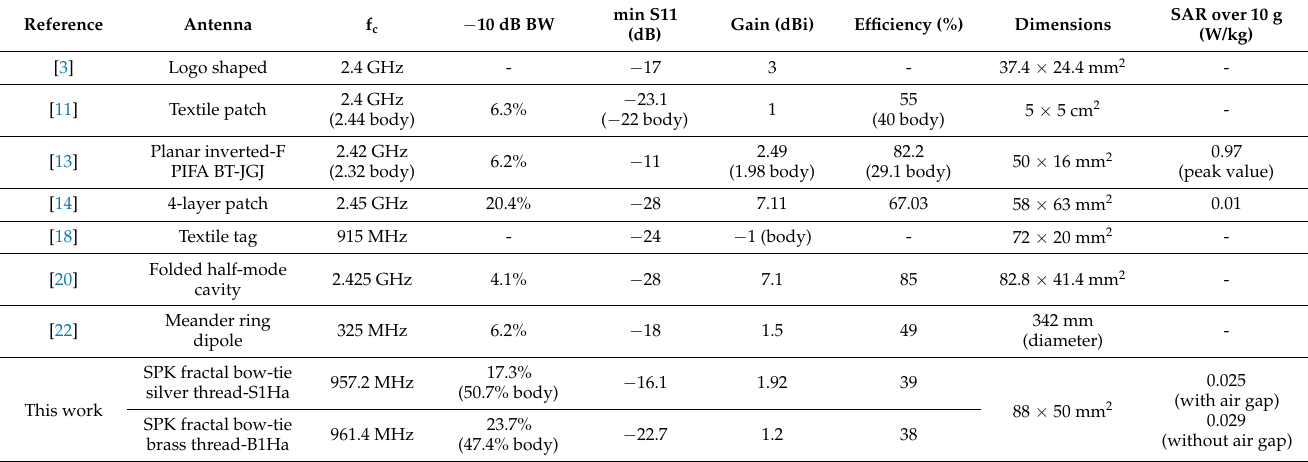
Table 6. Comparison of the proposed antennas with previous